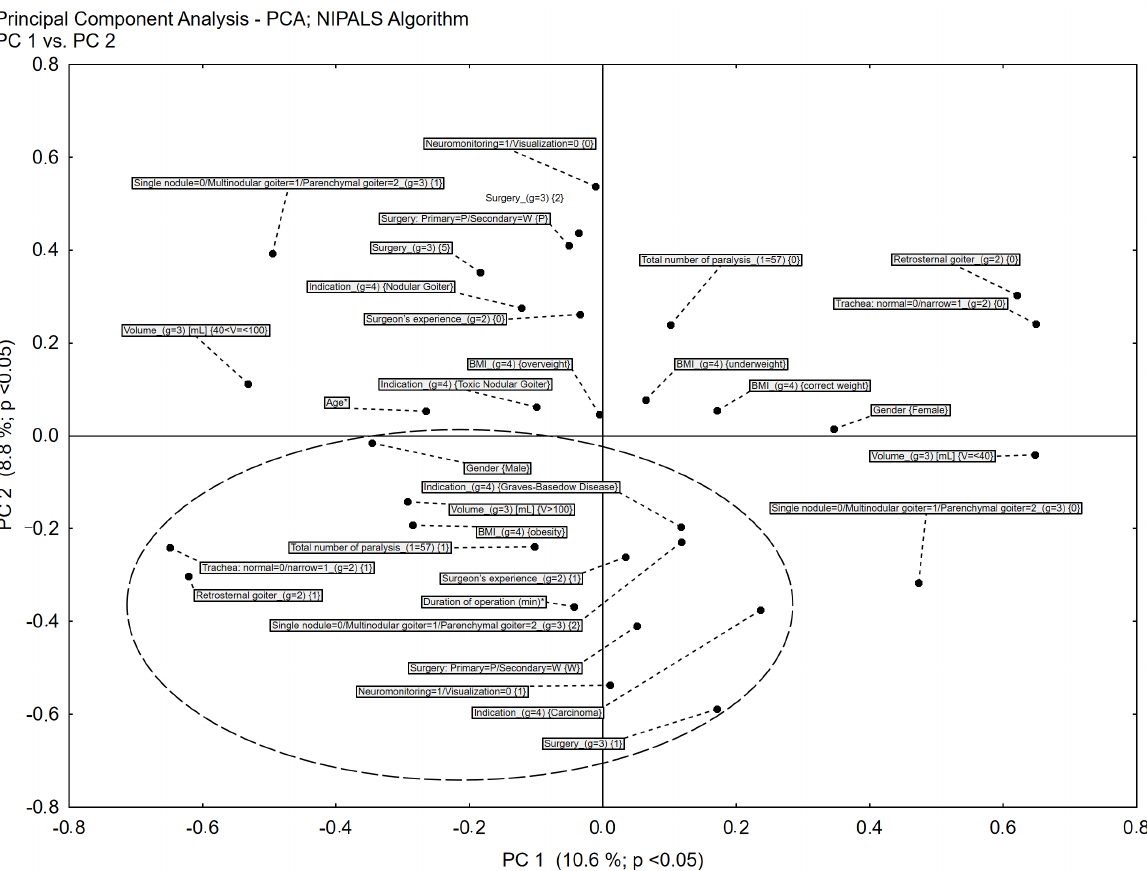
Figure 1. Principal component analysis of the relationship between risk factors and the total number of cases of vocal cord paralysis. Non-parametric tests for nominal variables based on Pearson’s chi2 statistics and the developed parametric logistic regression models confirmed the conclusions from the analysis of the results of the multidimensional data mining